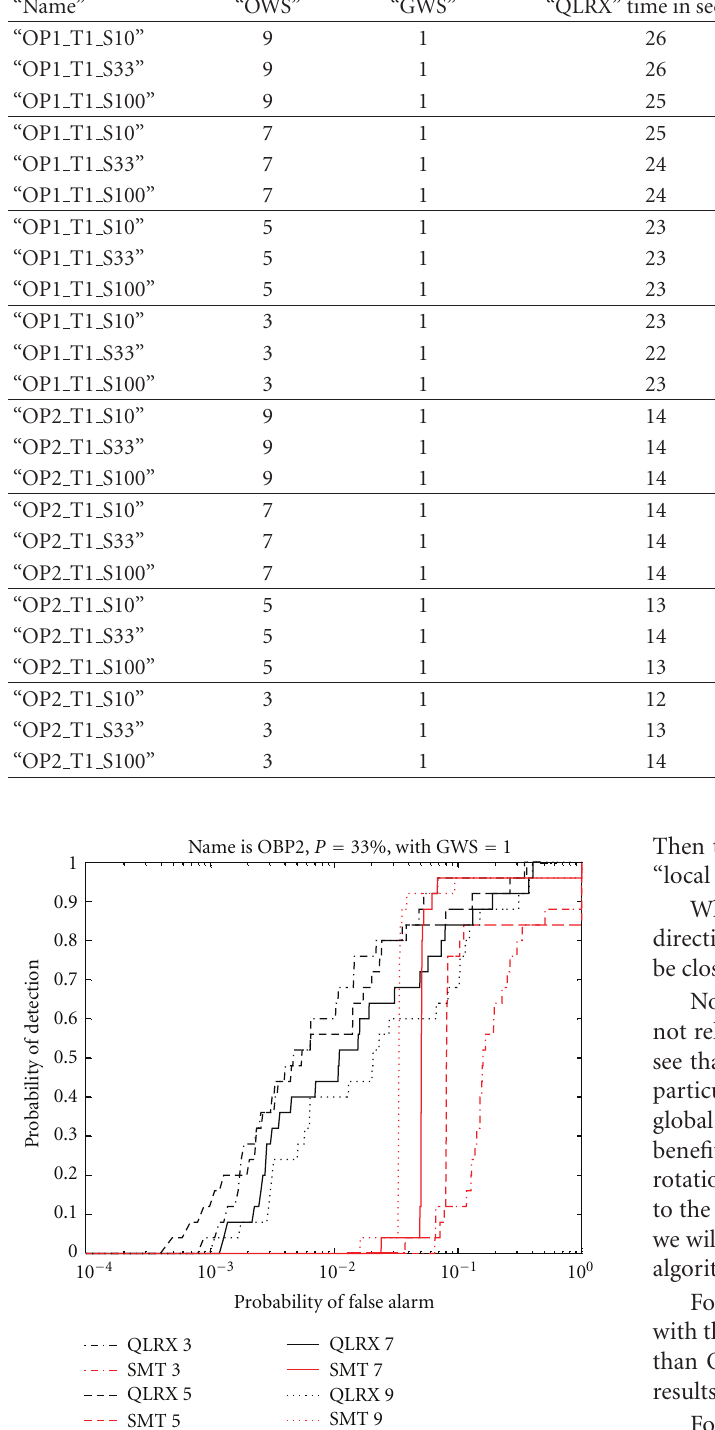
Figure 5: Similar to Figure 4 for the OBP2